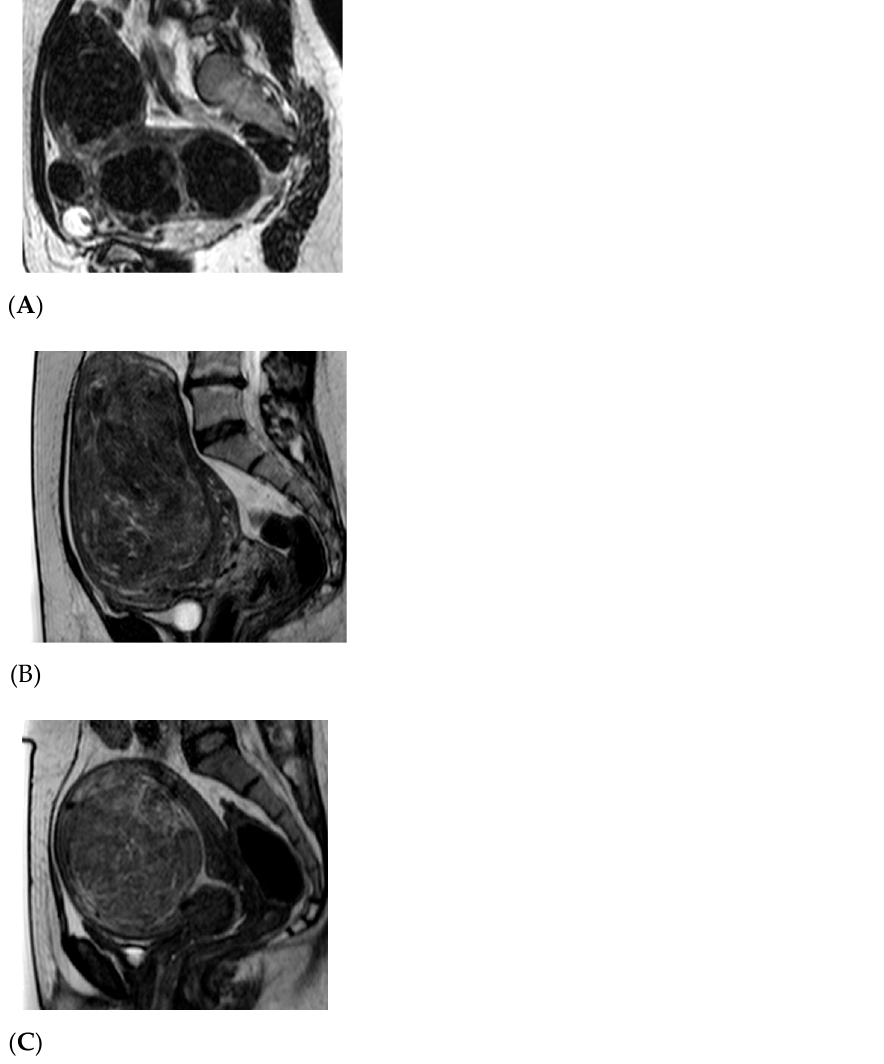
Figure 1. Magnetic resonance imaging (MRI) types of uterine fibroid (UF). ( A ). Type I presents as a “dark” UF as seen on MRI T2-weighted imaging. ( B ). Type II has a mixed MRI bright and dark structure. ( C ). Type III presents in MRI as a “bright” type of UF, usually not suitable for MRI-HIFU (high-intensity ultrasound) treatment.